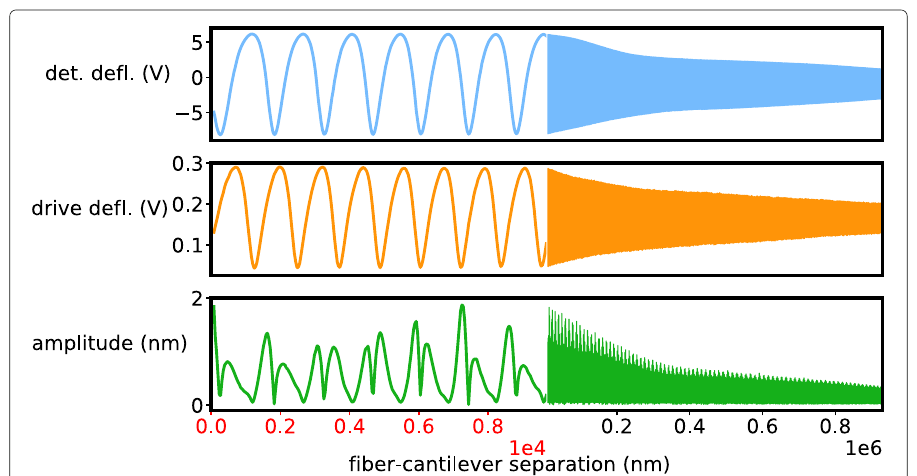
Fig. 5 Interference fringes of detection (1550 nm) (cyan) and excitation (1310 nm) (orange) lasers as a function of fiber-cantilever separation measured at 77 K in vacuum of 10 − 5 mbar